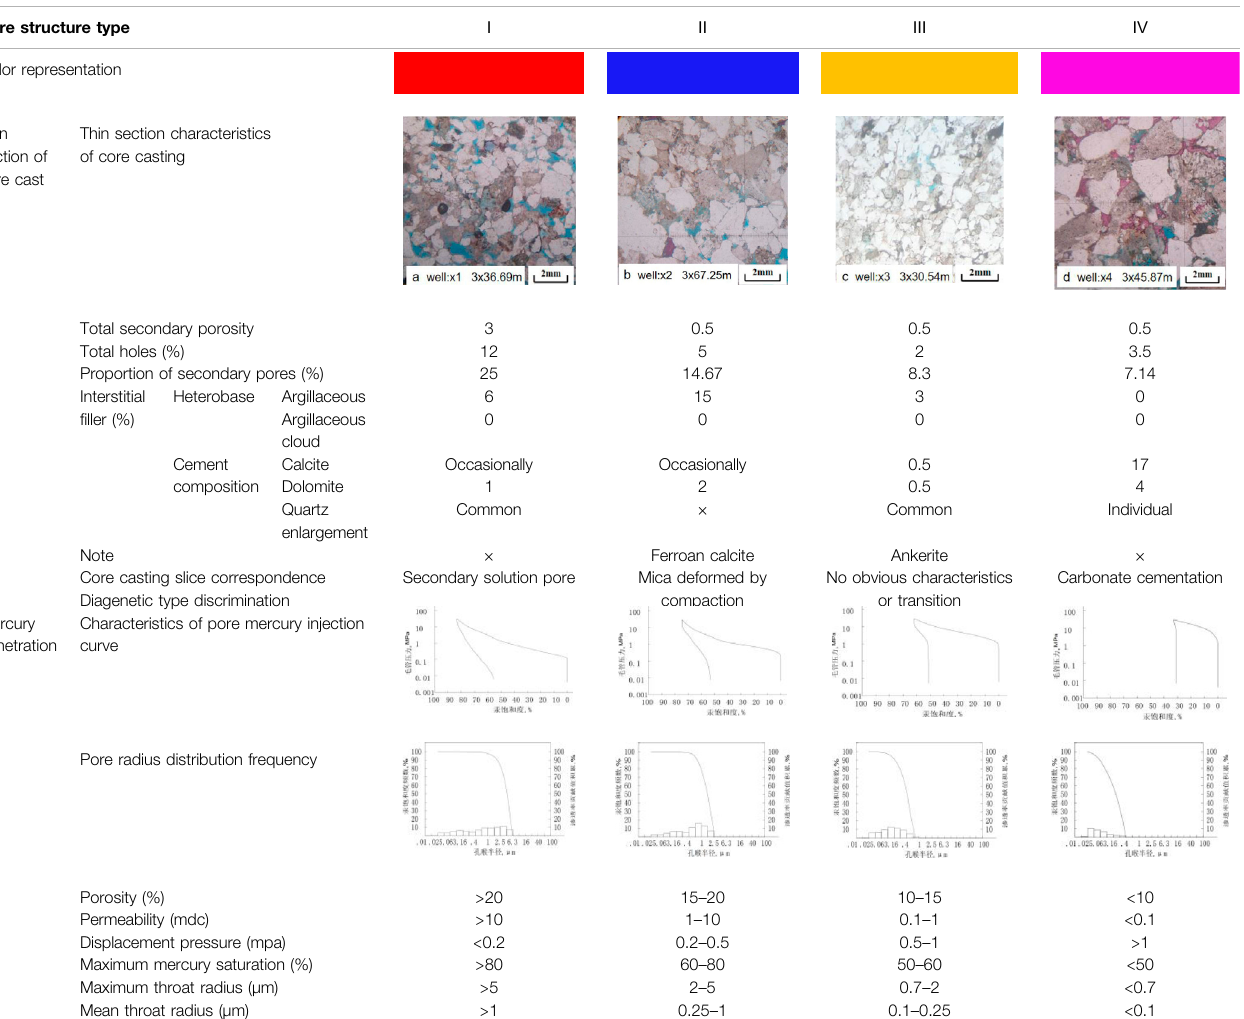
Mercury penetration